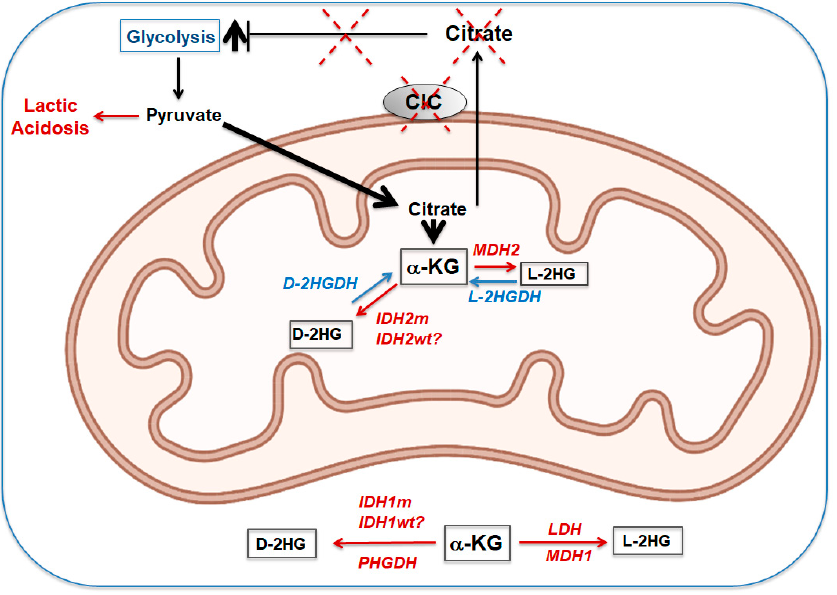
Figure 8. Mitochondrial and cytosolic pathways leading to D2-L2 hydroxyglutaric acid (D-L-2HG) accumulation (see text for explanation). The proposed model envisions that as a consequence of disruption of CIC-mediated citrate export activity, cytosolic citrate is reduced, leading to loss of the feedback loop on PFK. This leads to enhanced glycolysis and production of pyruvate, which, on one side, is converted to lactate, resulting in lactic acidosis. Excess pyruvate also enters mitochondria, where it is converted to citrate/isocitrate. Due to a lack of the export activity of CIC, this excess citrate is converted to TCA cycle intermediates downstream of citrate, leading to accumulation of α -KG and also of succinate, fumarate and malate (not shown in the figure), which are then secreted in urine. In red are the potential steps for conversion of α -KG to L-2HG or D-2HG, by either IDH1 or IDH2; in blue are the enzymes involved in the degradation pathway. IDH1/IDH2m or wt: mutant or wild-type forms of these enzymes. See text for additional